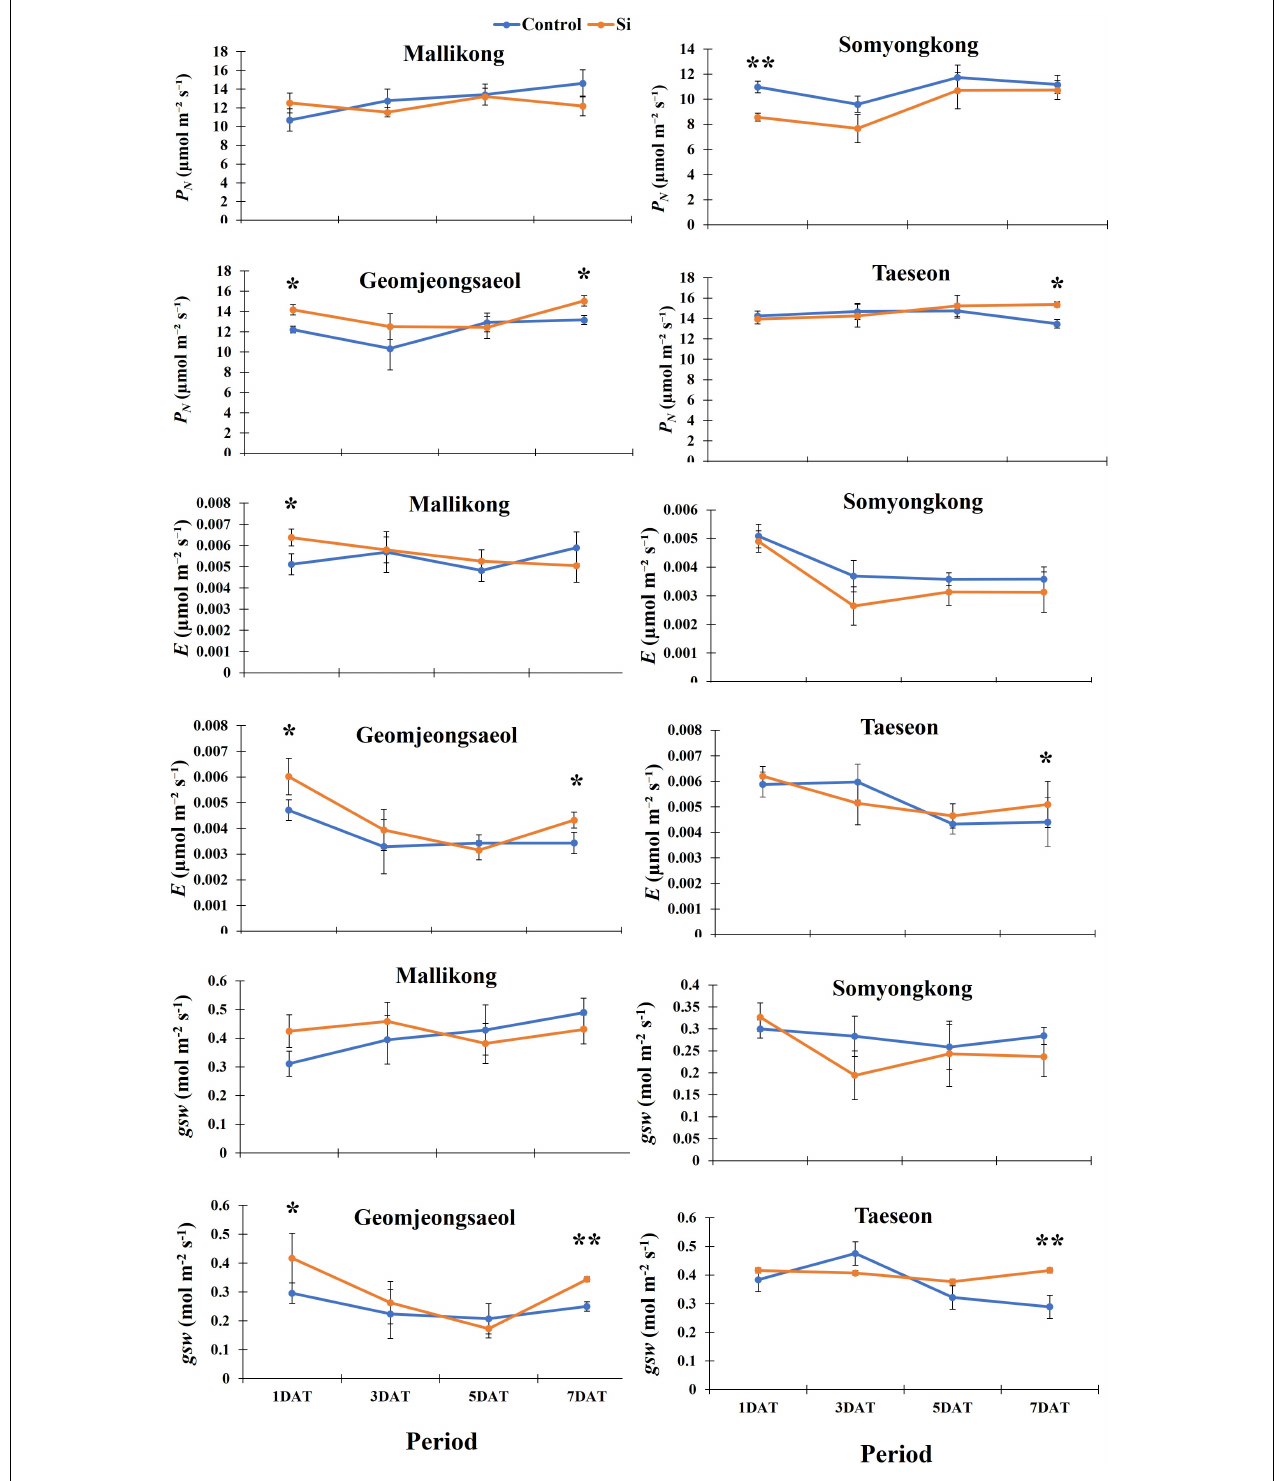
FIGURE 4 | Silicon effect on net photosynthesis ( P N ), transpiration rate ( E ), and stomatal conductance of water vapor ( g sw ) in selected soybean cultivars. The data were collected at different periods, and the blue and orange lines represent control and Si treatment, respectively. In the figure, each circle means average, and error bars in the circle indicate standard error. The experiment was conducted by five replications ( n = 5 ). Error bars indicate standard error, and the asterisks indicate significant difference using the Student’s t -test (*0.01 < P < 0.05; **0.001 < P < 0.01).